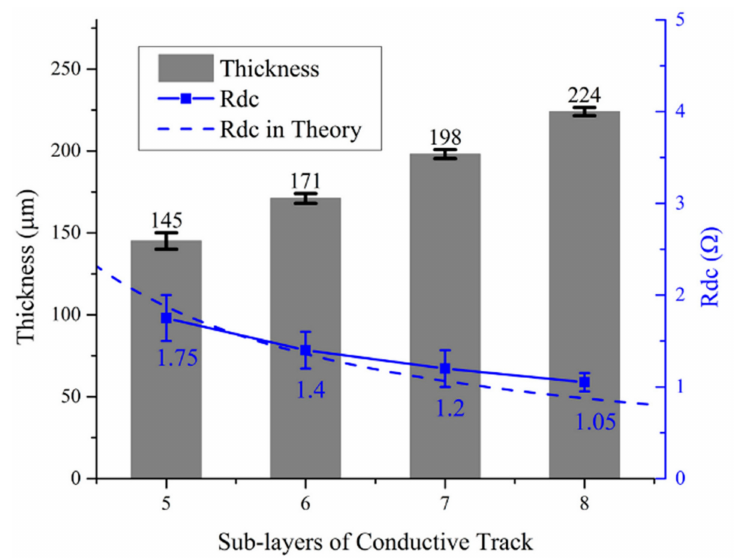
Figure 6. Thickness and practical DC resistance of printed conductive layer as designed coil compared with theoretical DC resistance in different number of sub-layers and